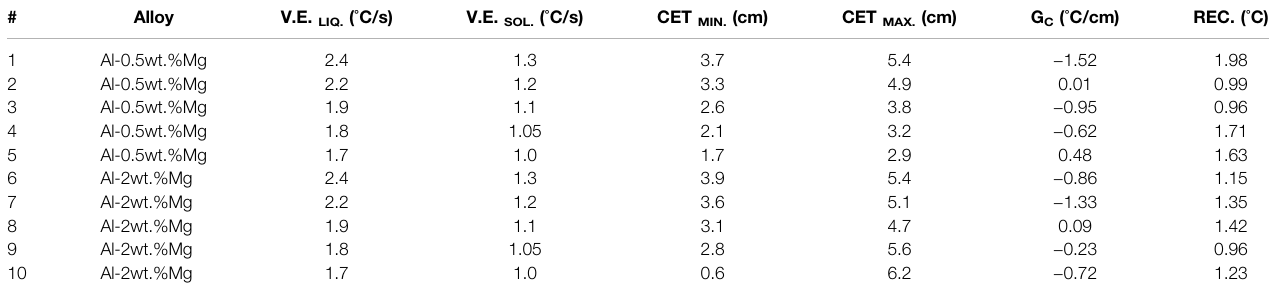
TABLE 1 | Cooling velocity in the liquid (V.E. LIQ. ) and cooling velocity in the solid (V.E. SOL. ), minimum CET position (CET MIN .) and maximum CET position (CET MAX. ), critical gradients (G C ) and recalescence values (REC.) obtained from the temperature versus time